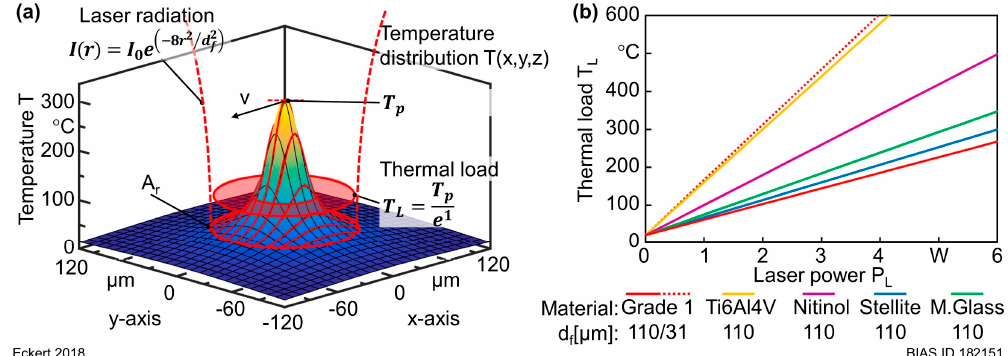
Figure 2. ( a ) Calculated surface temperature rise according to [25,26], and ( b ) correlation between laser power P L and thermal load T L for the different investigated materials.